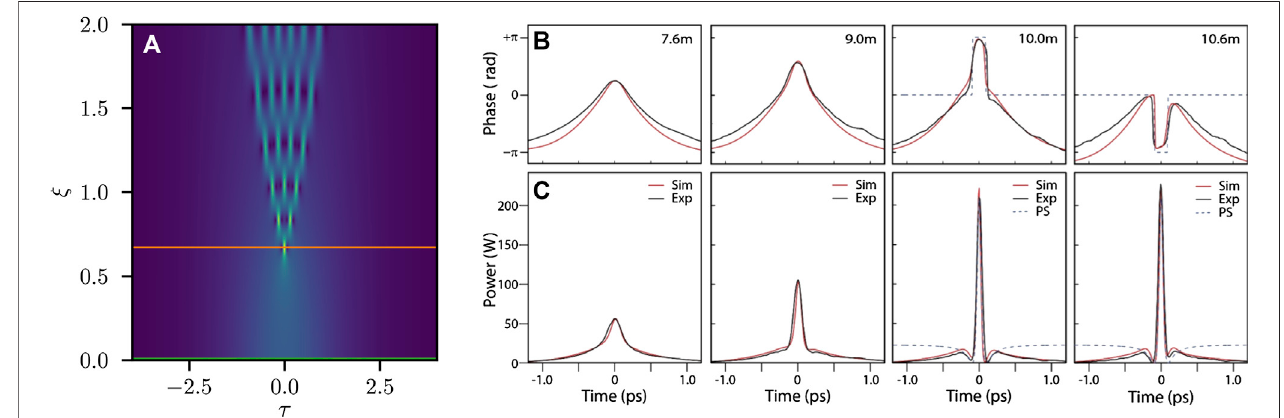
FIGURE 1 | Local emergence of the Peregrine soliton in the process of pulse compression. (A) Numerical simulations: space – time dynamics of a single hump, reproduced with permission from Ref. 24. (B) Intensity and (C) phase measurements of compressed pulse characteristics in optical fi ber at the distances indicated, comparingexperiment(blackline)withsimulations(redline).Fortheresultsat10.0and10.6 m,thereisa fl ipinthephasecharacteristicsacrossthecentralintensitylobe. Dashed lines are the theoretical pro fi les of an ideal Peregrine soliton, reproduced with permission from Ref.